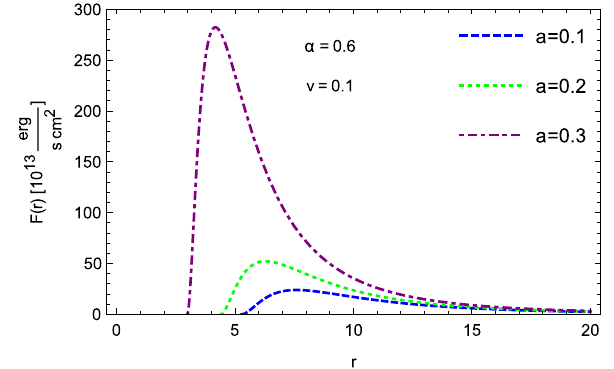
Fig. 5 The energy flux F ( r ) from a disk around a charged, slowly rotating dilaton black hole with mass accretion rate ˙ M = 2 × 10 − 6 M (cid:10) year − 1 , for α = 0 . 6, v = 0 . 1 and different values of rota- tion parameter a = 0 . 1 , 0 . 2 , 0 . 3